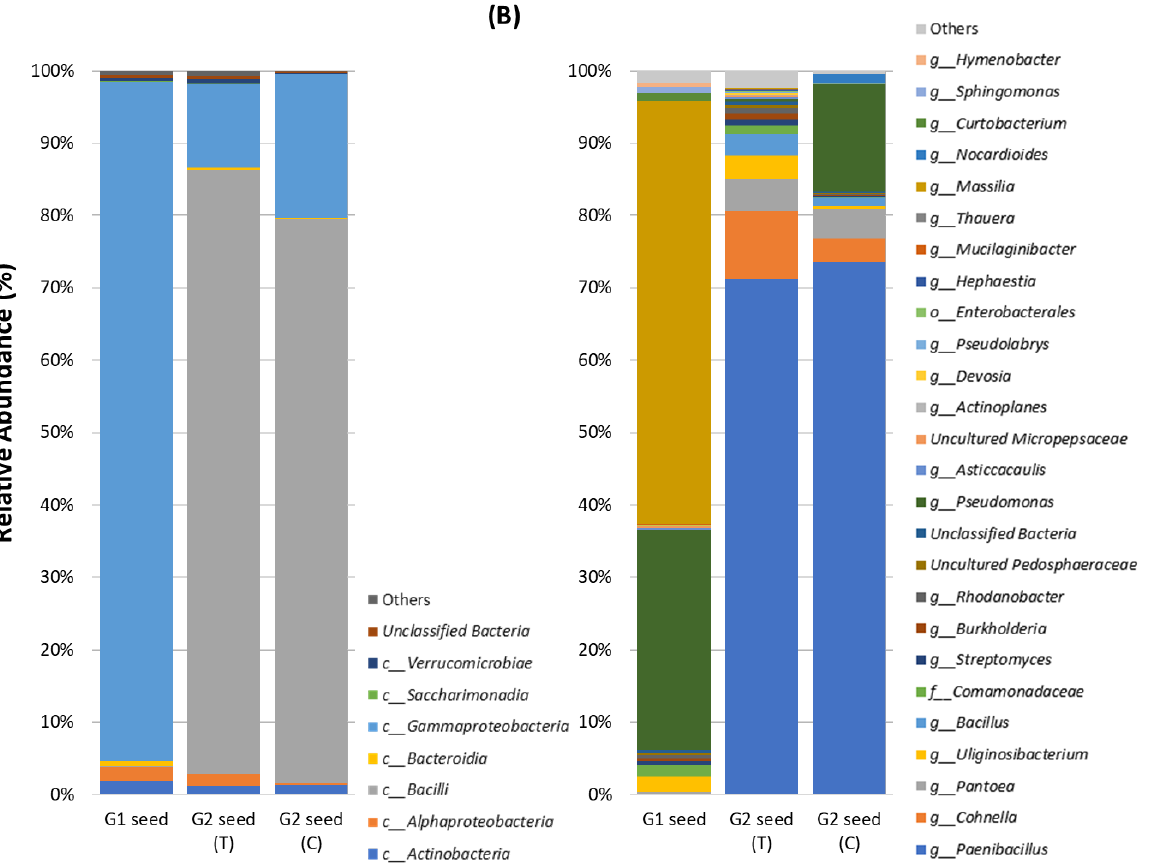
Figure 3. Relative abundance of G. clandestina microbiomes across G1, G2 (T) and G2 (C) seed at the class ( A ) and genus level ( B ). Taxa occurring with less than 0.1% relative abundance are shown as “Others”.